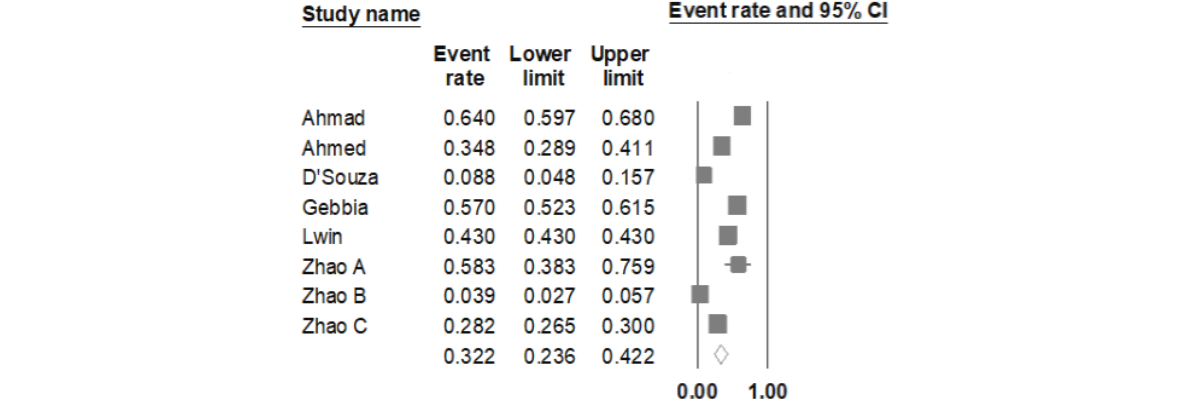
Figure 2. Forest plot of fear random event rates 95% CI due to Covid-19 surge retrieved by infodemics.